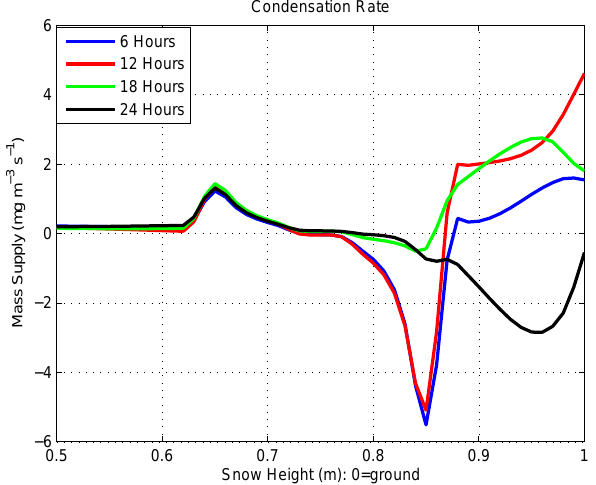
Figure 15. Snowpack condensation rates over a 24h period based on the diurnal boundary condition of Eq. (98). Positive values indi- cate condensation while negative values indicate